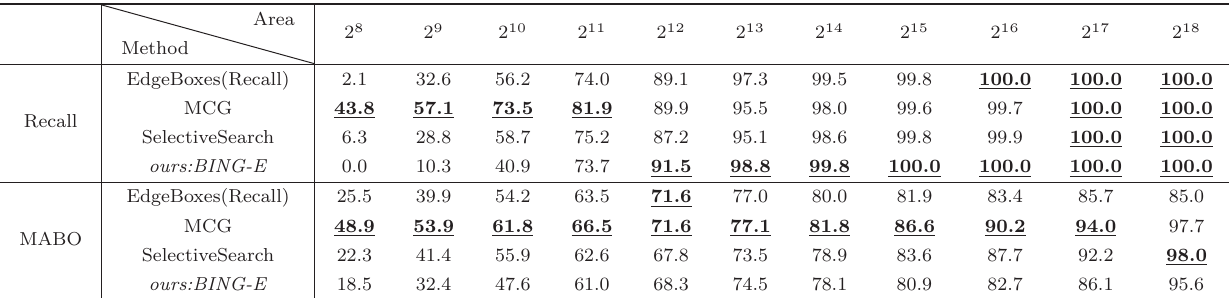
Table 6 Recall/MABO (%) vs. area on VOC2007 test set with 1000 proposals and IoU threshold 0.5